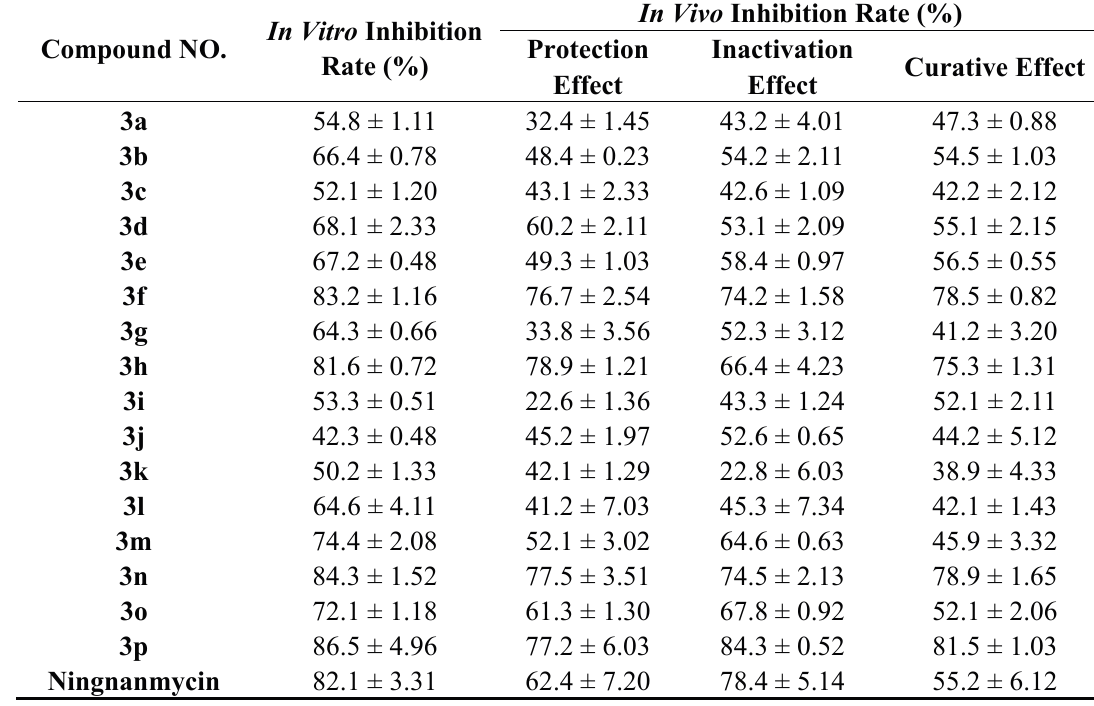
Table 1. Anti-TMV activity of compounds in vitro and in vivo at 500 mg/mL. Compound